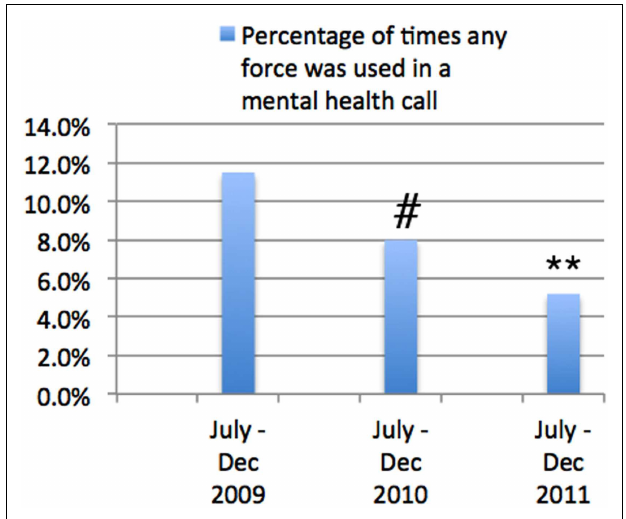
FIGURE 7 | Change in the Use of Force in mental health calls (July–December). This shows the percentage of times that any type of force was used in a mental health call. It can be seen that there was a highly statistically significant decrease in the percentage of times force was used both between 2009 and 2010 (# p < 0.001) and between 2010 and 2011 (** p < 0.001). However, it should be noted that there were other training activities in the 6-month period (September 2010–March 2011) prior to the current training program that are also likely to have impacted this reduction in the use of force. It is therefore likely that the current training program was one contributor to this significant reduction, but not likely to be the sole reason for this